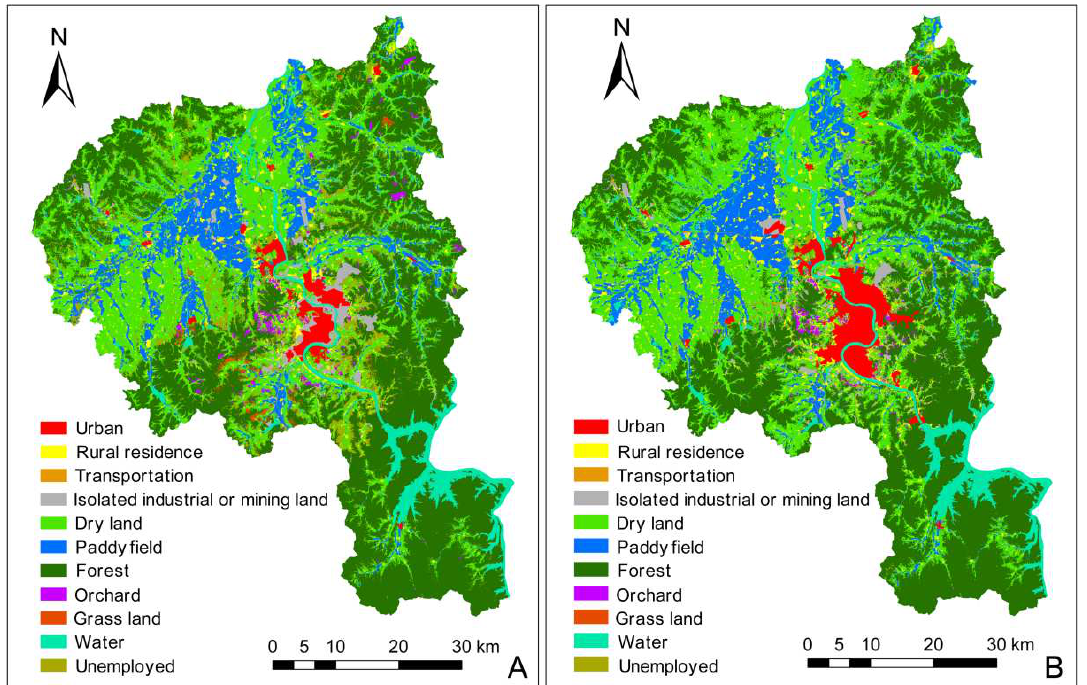
Figure 3. Land use maps in 1989 (A) and 2005 (B) in metropolitan Jilin